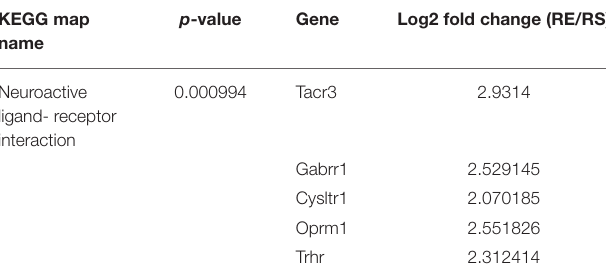
TABLE 6 | The list of changed gene by exercise-induced EVs, fold change means restraint exercise/restraint sedentary.